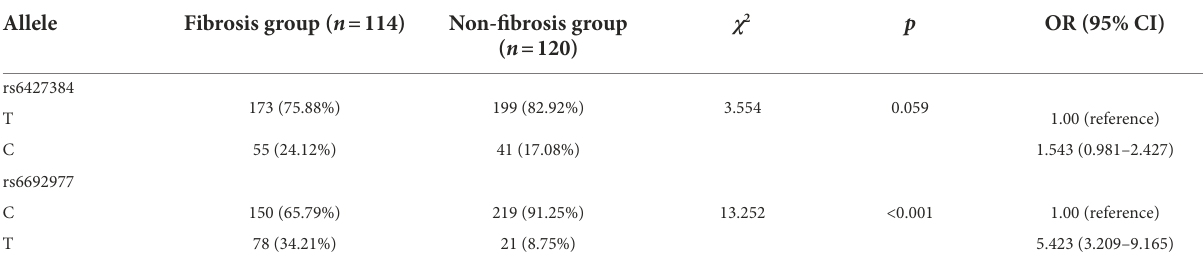
TABLE 3 Comparison of allele frequencies of FCRL5 gene SNPs between fibrosis and non-fibrosis group.